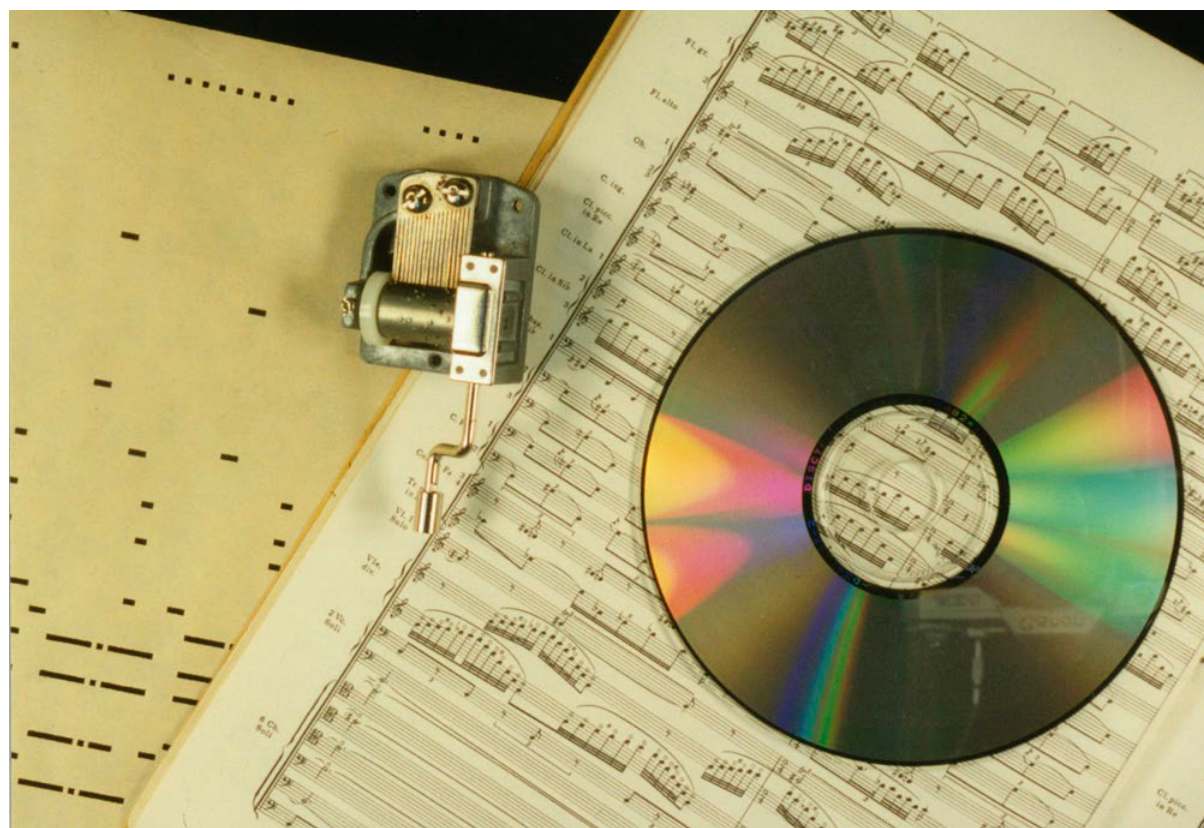
Figure 1. Four digital storage media. (a) The cylinder and comb from a music box play 16 bars from Lara’s Theme (M. Jarre). The 18 tines of the comb have different masses and thus play different notes when struck by spikes on the cylinder. It has 18 parallel channels – circles round the cylinder. The loudness is binary (spike or no spike, note or no note). The timing is in principle analog, but is here quantised in multiples of 1/12 of a bar. The uncompressed data content of this cylinder is therefore 18 x 12 x 16 = 3456 bits. (b) The pianola roll in the background also has parallel binary channels, but the length of the hole determines the time the strings sound before the damper is replaced. In that sense, both duration and timing could be analogue, but again they are quantised in this example. The uncompressed data content is 35,000 bits per metre. (c) Standard Western music notation is (largely) parallel binary digital coding: each line and space (parallel chan- nels) represents a pitch, though that pitch can be varied by sharps and flats. The time coding is encoded digitally in symbols (see Fig 2). This example ( The Rite of Spring , I. Stravinsky) has about 30,000 bits on this page, which lasts a few seconds, using a coding somewhat like that in Fig 2c. (d) The CD also carries a binary digital signal (“pit” or “no-pit” in the track) but it is different in all other aspects. The signal is car- ried in serial rather than in parallel, and it encodes numbers that are proportional to the pressure of a sound wave. This CD records about 5 x 109 bits, not counting error correction bits. The storage efficiencies are approximately: a) 5 x 10 5 bit.kg1, b) 10 6 bit.kg -1 , c) 10 7 bit.kg -1 ,